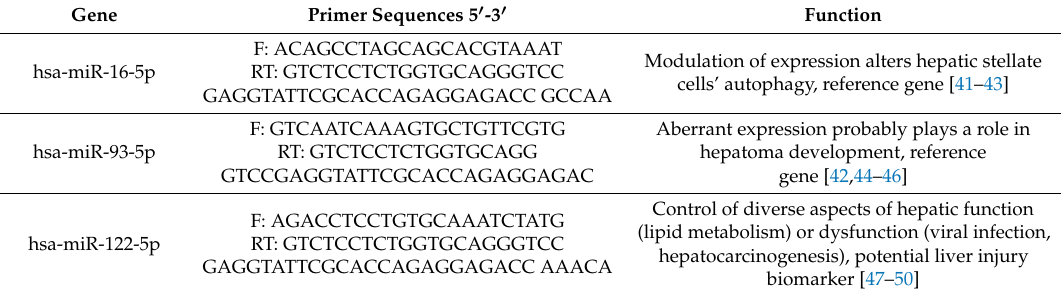
Table 2. List of selected genes, their functions and sequences of primers